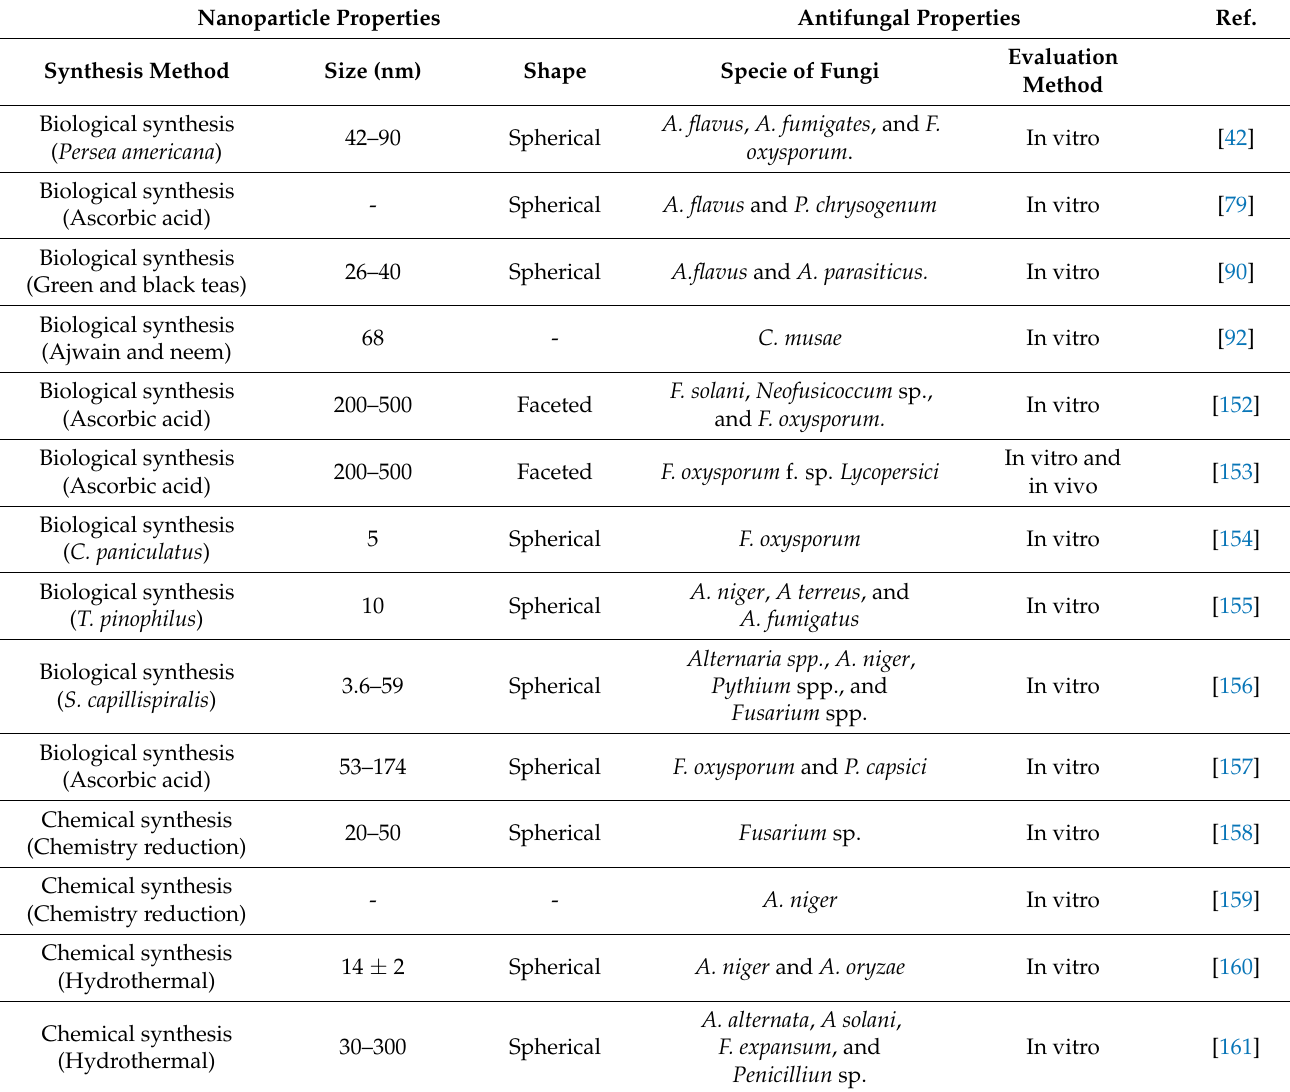
Table 2. Characteristics and antifungal evaluations of Cu